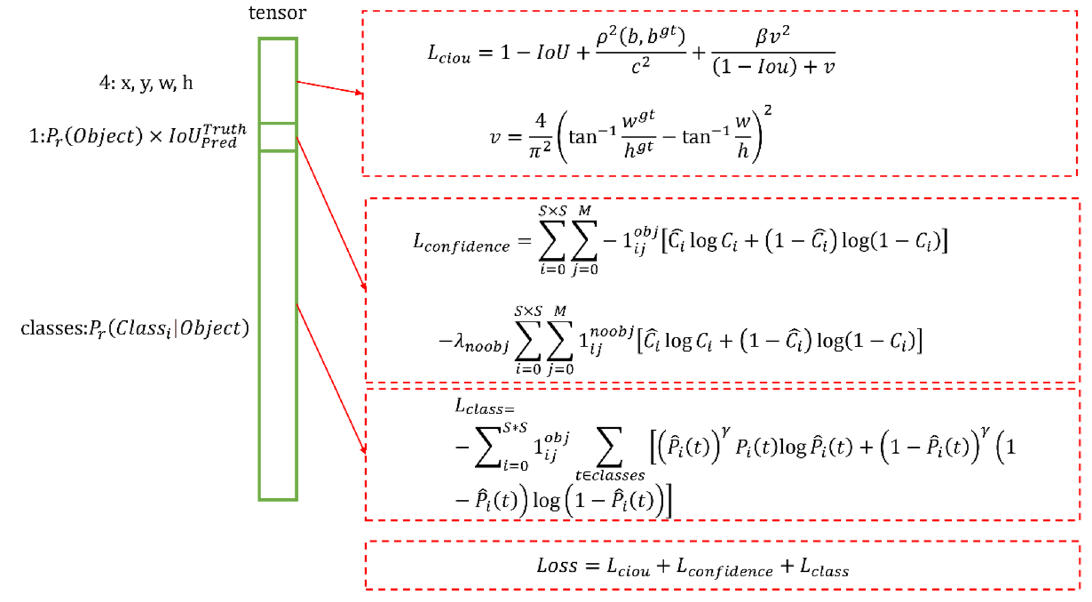
Figure 3. C-YOLOv4 loss function. S × S is the number of grid points, and M is the number of anchor boxes on obj each grid. 1 ij corresponds to whether a target is present in the grid (existence is 1, otherwise it is 0), opposite, and (cid:31) noobj is used to balance positive and negative samples. The anchor box corresponding to each grid has a confidence level C i